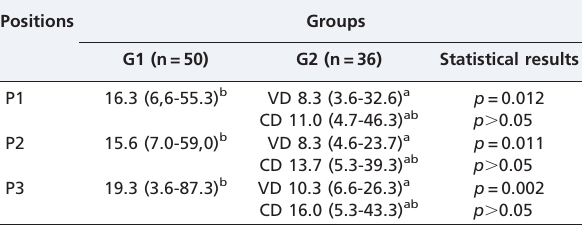
Table 4 - Maximum amplitude of PFM contractions (cmH 2 O) (median and range) in the nulliparous compared to the primiparous 45 days postpartum group according to the type of delivery measured using a perineometer in different positions: supine with the lower limbs straight (P1), supine with the lower limbs bent (P2), and sitting (P3). Different lower-case letters indicate significant differences between groups at the same time point.